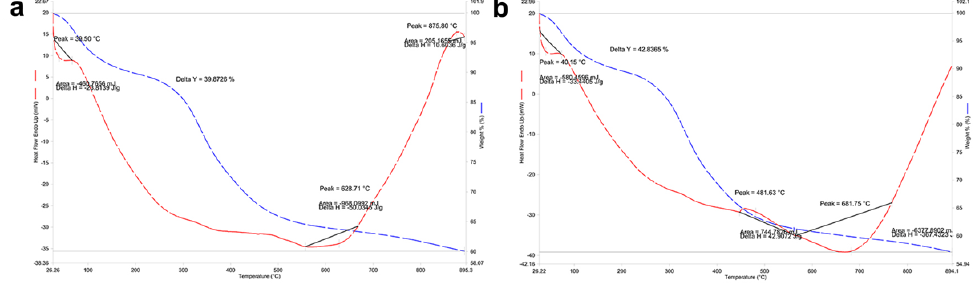
Figure 10. Differential Scanning Calorimetry DSC (transitions-purity) in mandibular bone. ( a ) Farmed fish. ( b ) Wild fish. TGA-DSC STA6000, Perkin Elmer, Waltham, MA,